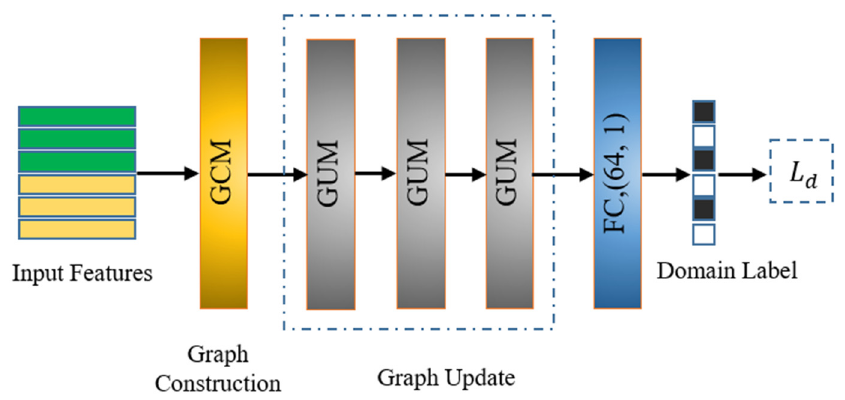
Figure 6. Structure of the proposed GDAN.